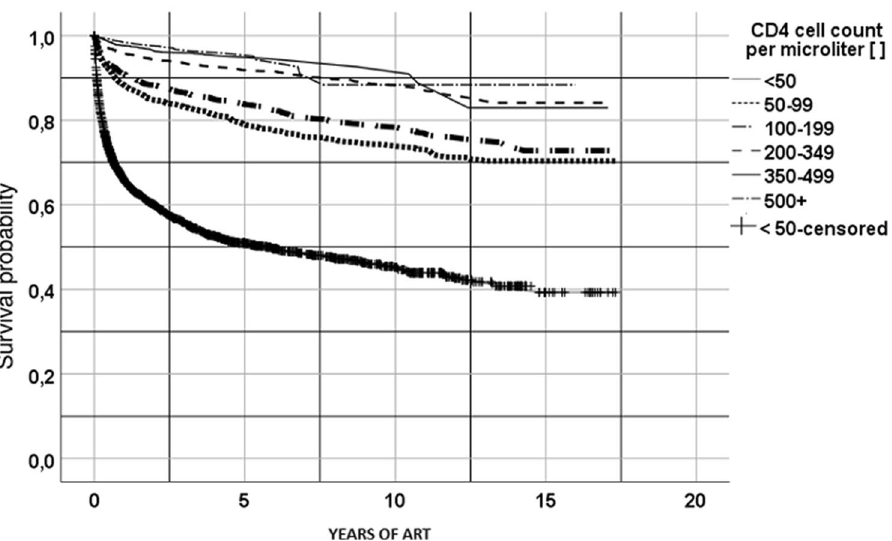
Figure 3. Kaplan–Meier plot for PLHIV on ART at Carmelo Hospital of Chókwè (2002–2019), by CD4 cell count per